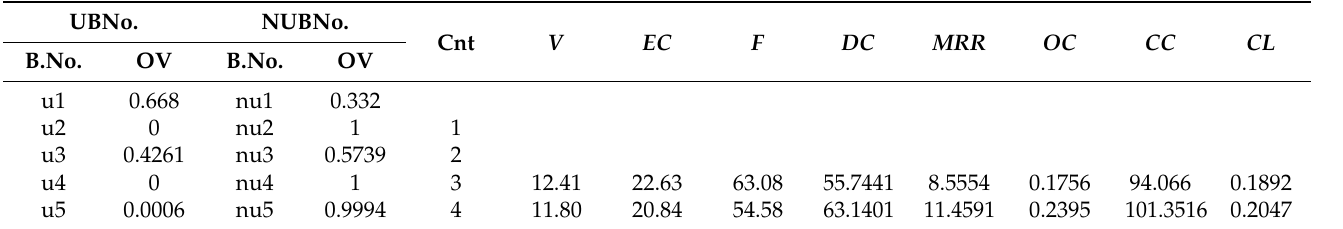
Table A15. Comparison of new values with unemployed bees.